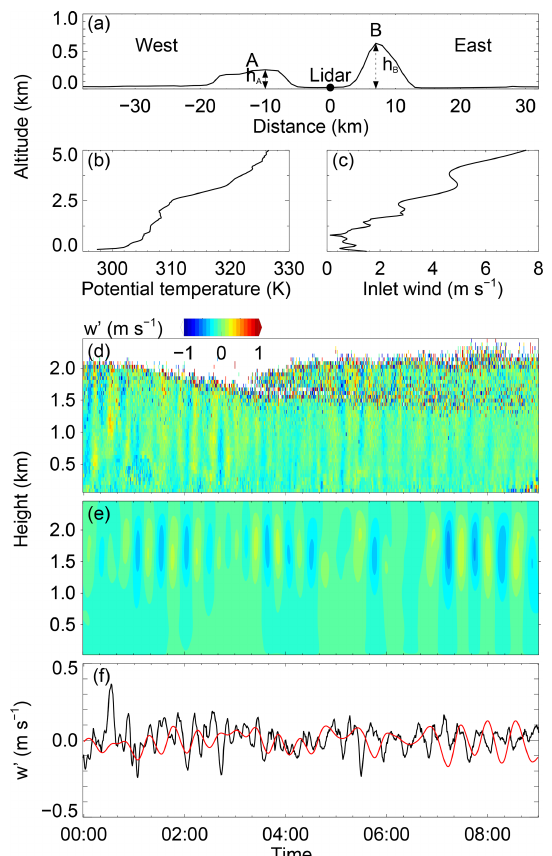
Figure 7. (a) The topography used in CFD simulations. A/B rep- resents west/east hill. The heights of A and B are represented by h A and h B , respectively. (b) The vertical profile of potential tem- perature used in the CFD model. (c) The vertical profile of the inlet wind in the CFD model. (d) The vertical wind perturbation from li- dar 00:00–09:00 on 5 September 2018. A mean value is subtracted. (e) The CFD-simulated results of vertical wind. (f) Observed (black) and simulated (red) vertical perturbations at 1km altitude. The ob- served perturbation is smoothed with five-point